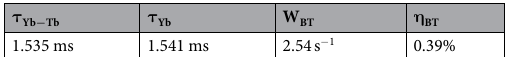
Table 4. Backward energy transfer data (Tb 3 + : 5 D 4 → 2Yb 3 + : 2 F 5/2